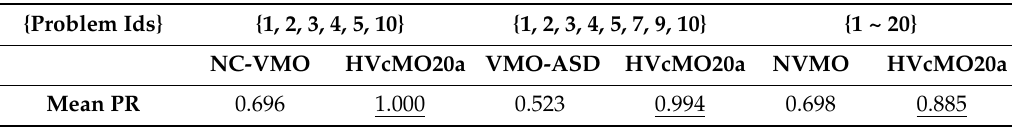
Table 3. Peak ratios reached by the VMO-based multimodal optimizers, averaged at all accuracy levels over sets of 6, 8 and 20 benchmark problems.